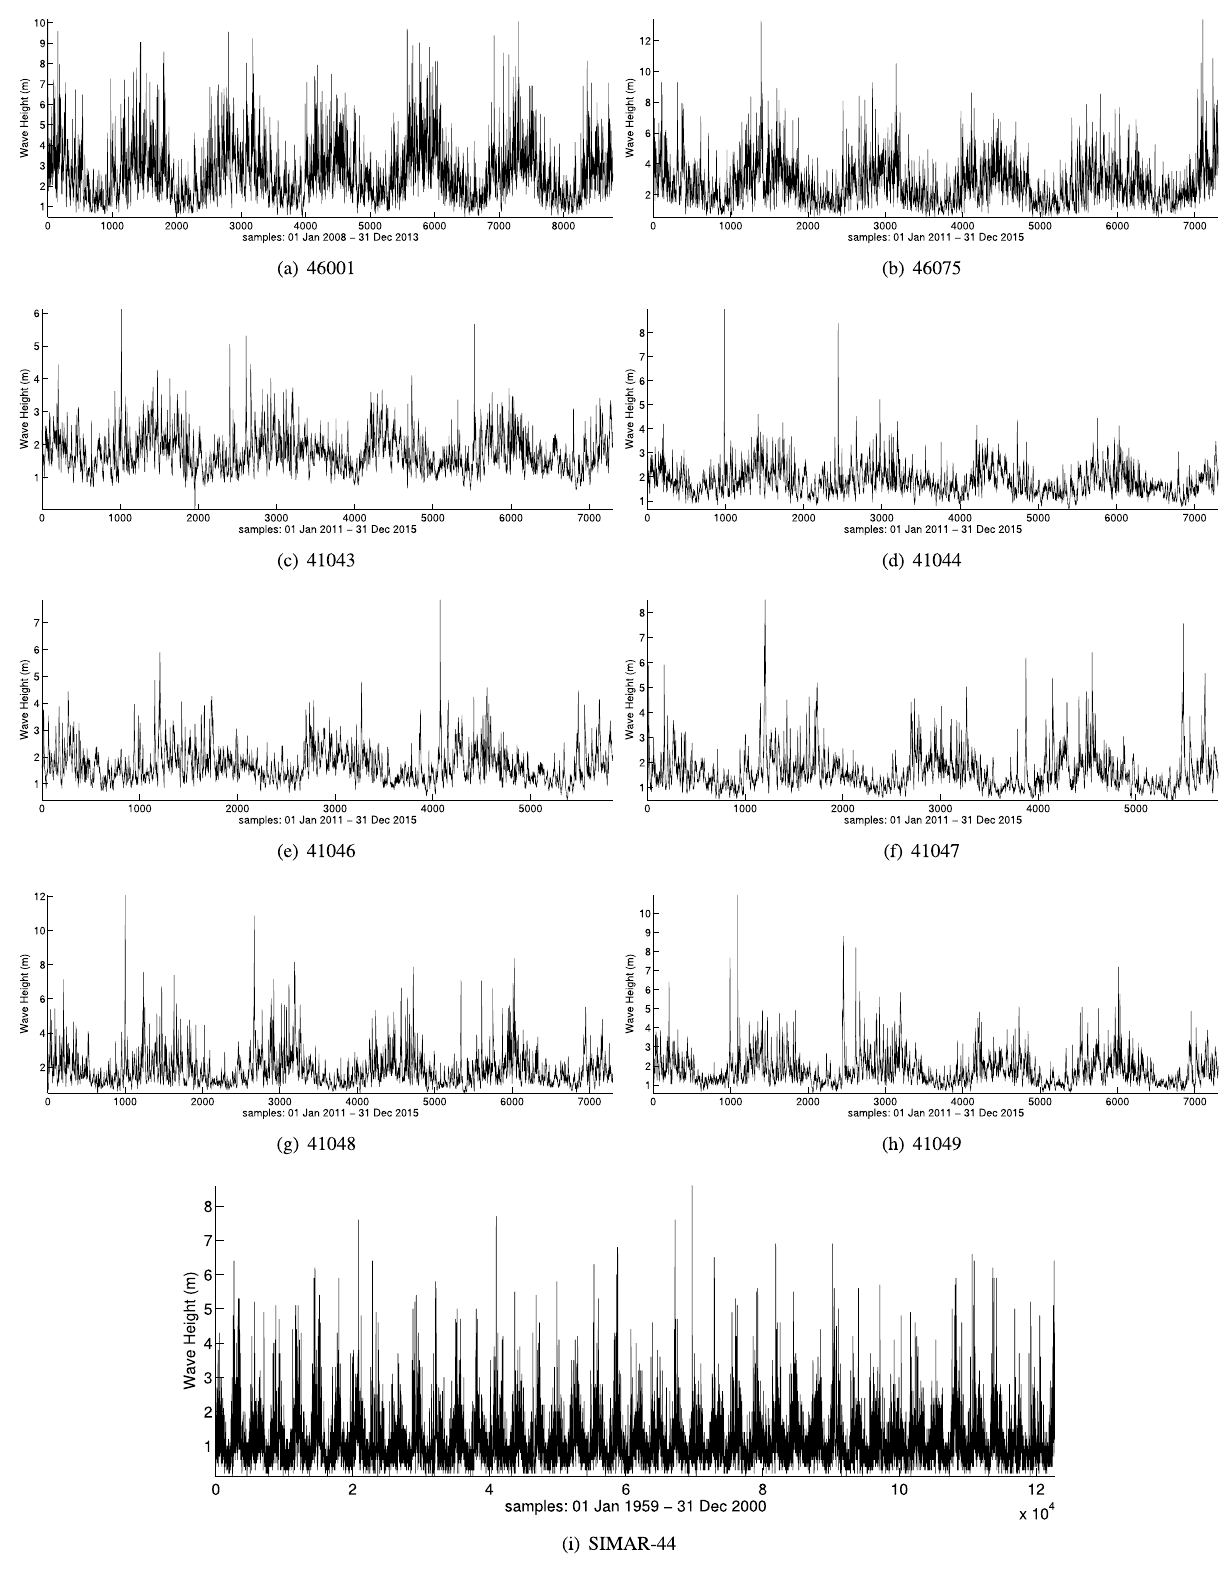
Figure 2. Graphical representation of the time series recorded for every